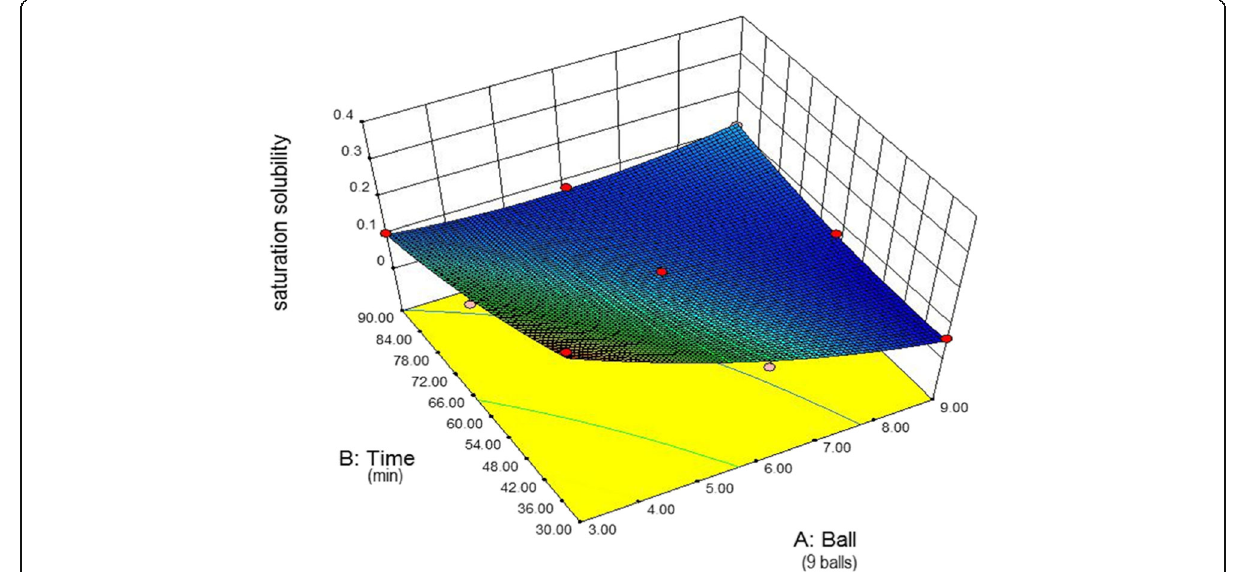
Fig. 3 Response surface curve showing effect of number of balls and time on Saturation Solubility